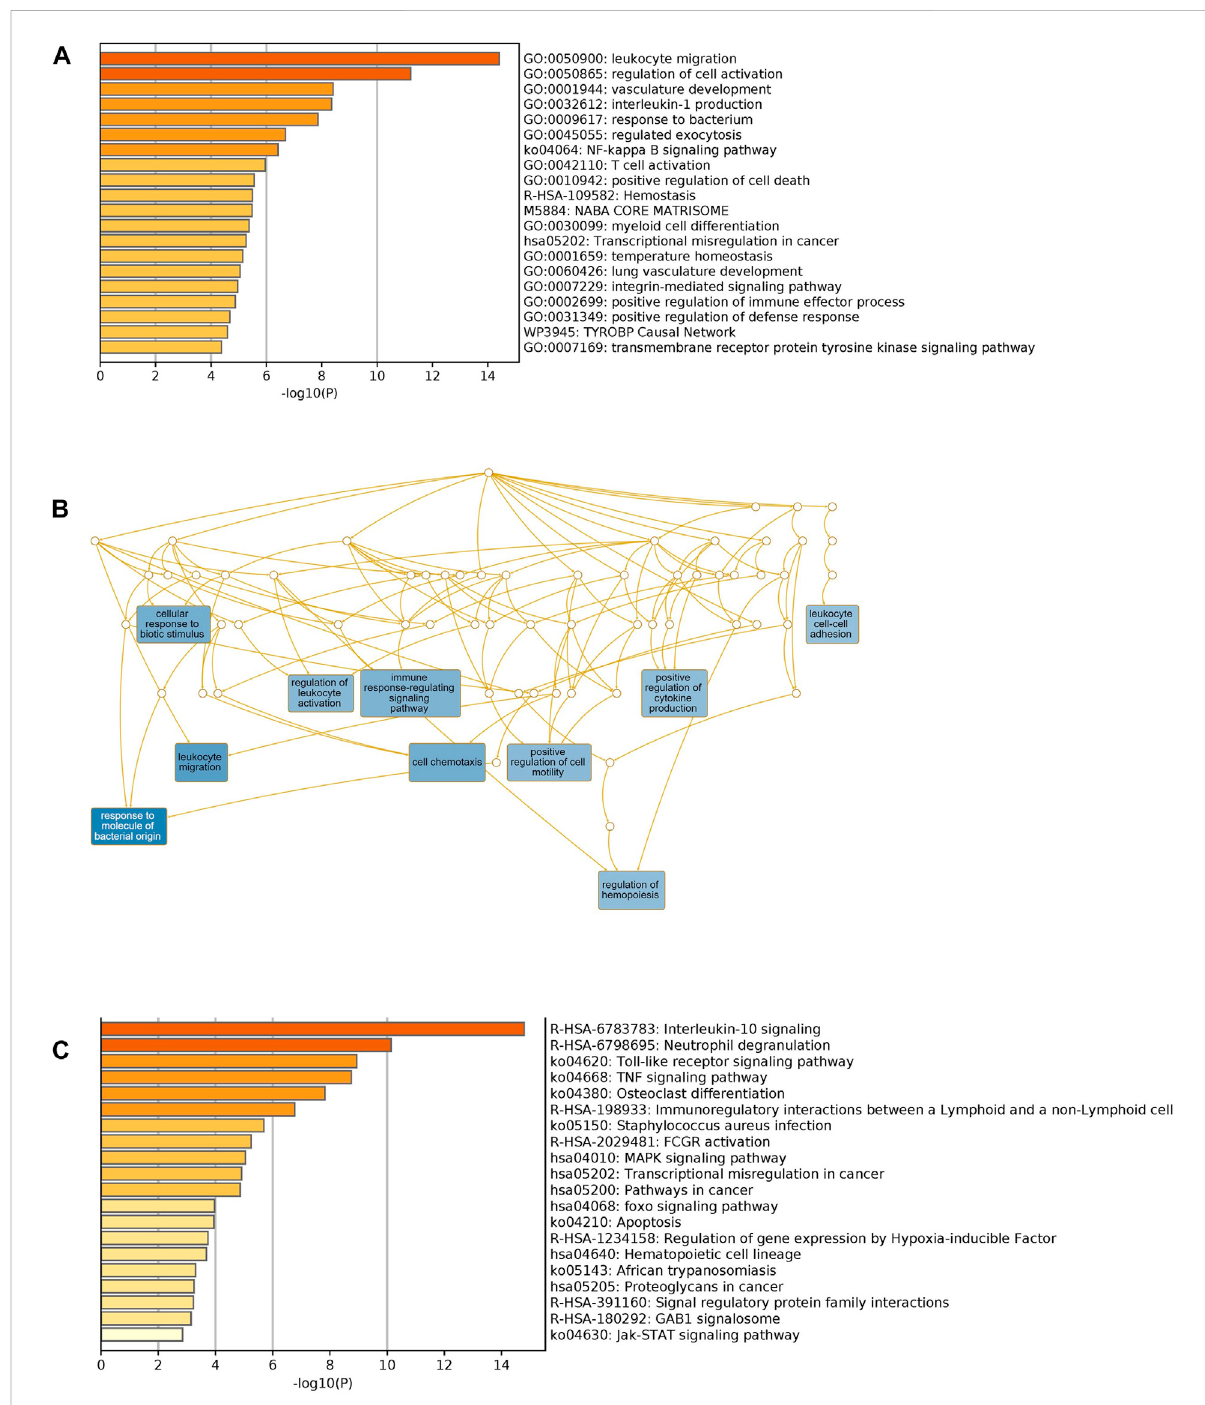
FIGURE 6 Functional enrichment of shared comorbidities-COVID-19 DEGs. (A) Bar graphs showing most signi fi cant biological processes. (B) Network illustrates the major non-redundant biological process. DEGs are enriched in biological processes related to leukocyte migration, T cell activation, regulation of hemopoiesis and integrin pathway. (C) Top Shared pathways; IL-10, TLRs and TNF signaling. The bar graphs were generated using Metascape (http://metascape.org) to illustrate the most enriched pathways and the Network was generated using WebGestalt (http://www.